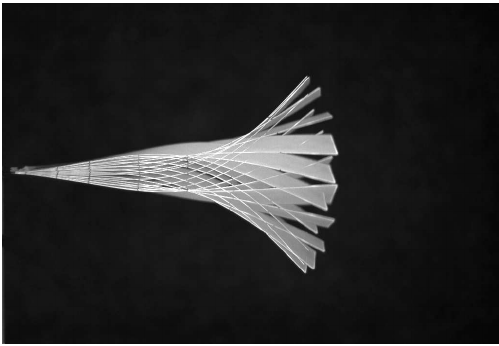
( f ) 26 cm flag experimental.